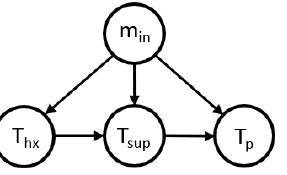
Figure 14. Causal relations between